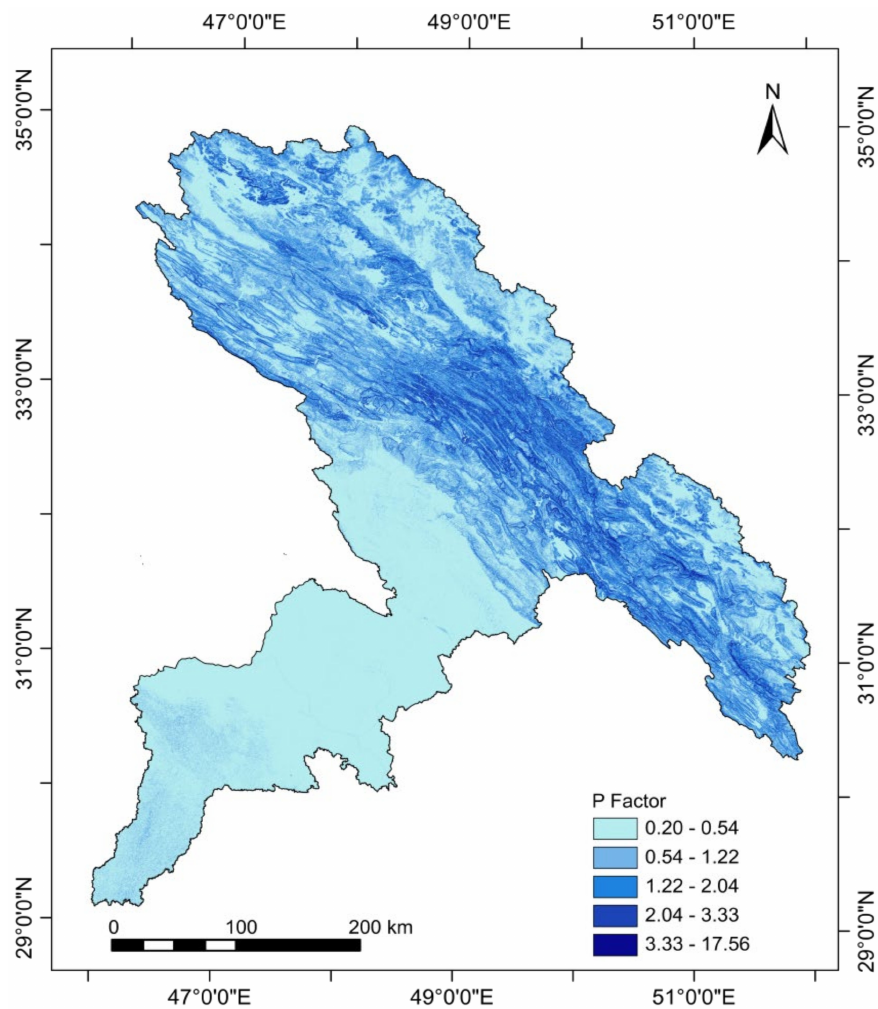
Figure 7. Spatial distribution of P factor in the study